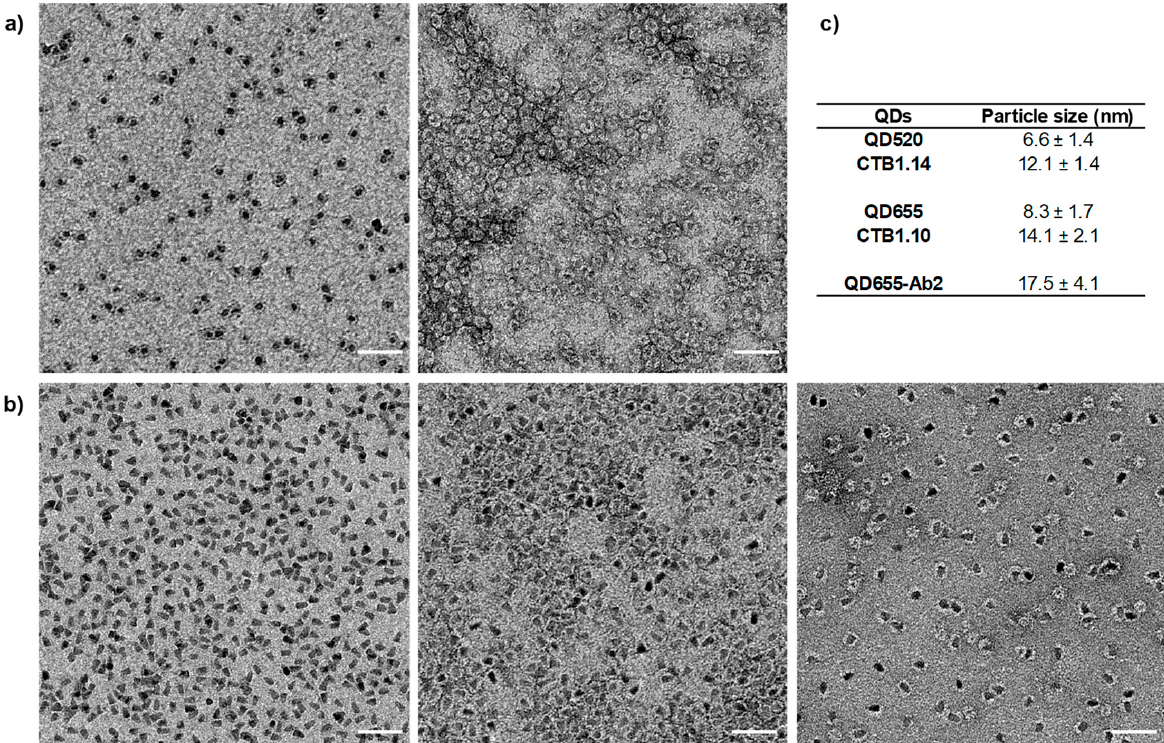
Figure 2. Transmission electron microscopy images of PEG-coated QDs, unconjugated, conjugated to SpA and commercially available QDs conjugated to secondary antibodies. ( a ) Unconjugated PEG coated QD520 ( left ) and bioconjugated QD520 to SpA, CTB1.14 ( right ). ( b ) Unconjugated PEG coated QD655 ( left ), bioconjugated QD655 to SpA, CTB1.10 ( center ) and commercially available QDs conjugate to secondary antibody ( right ). ( c ) Size of the different QDs analyzed. Scale bar 50